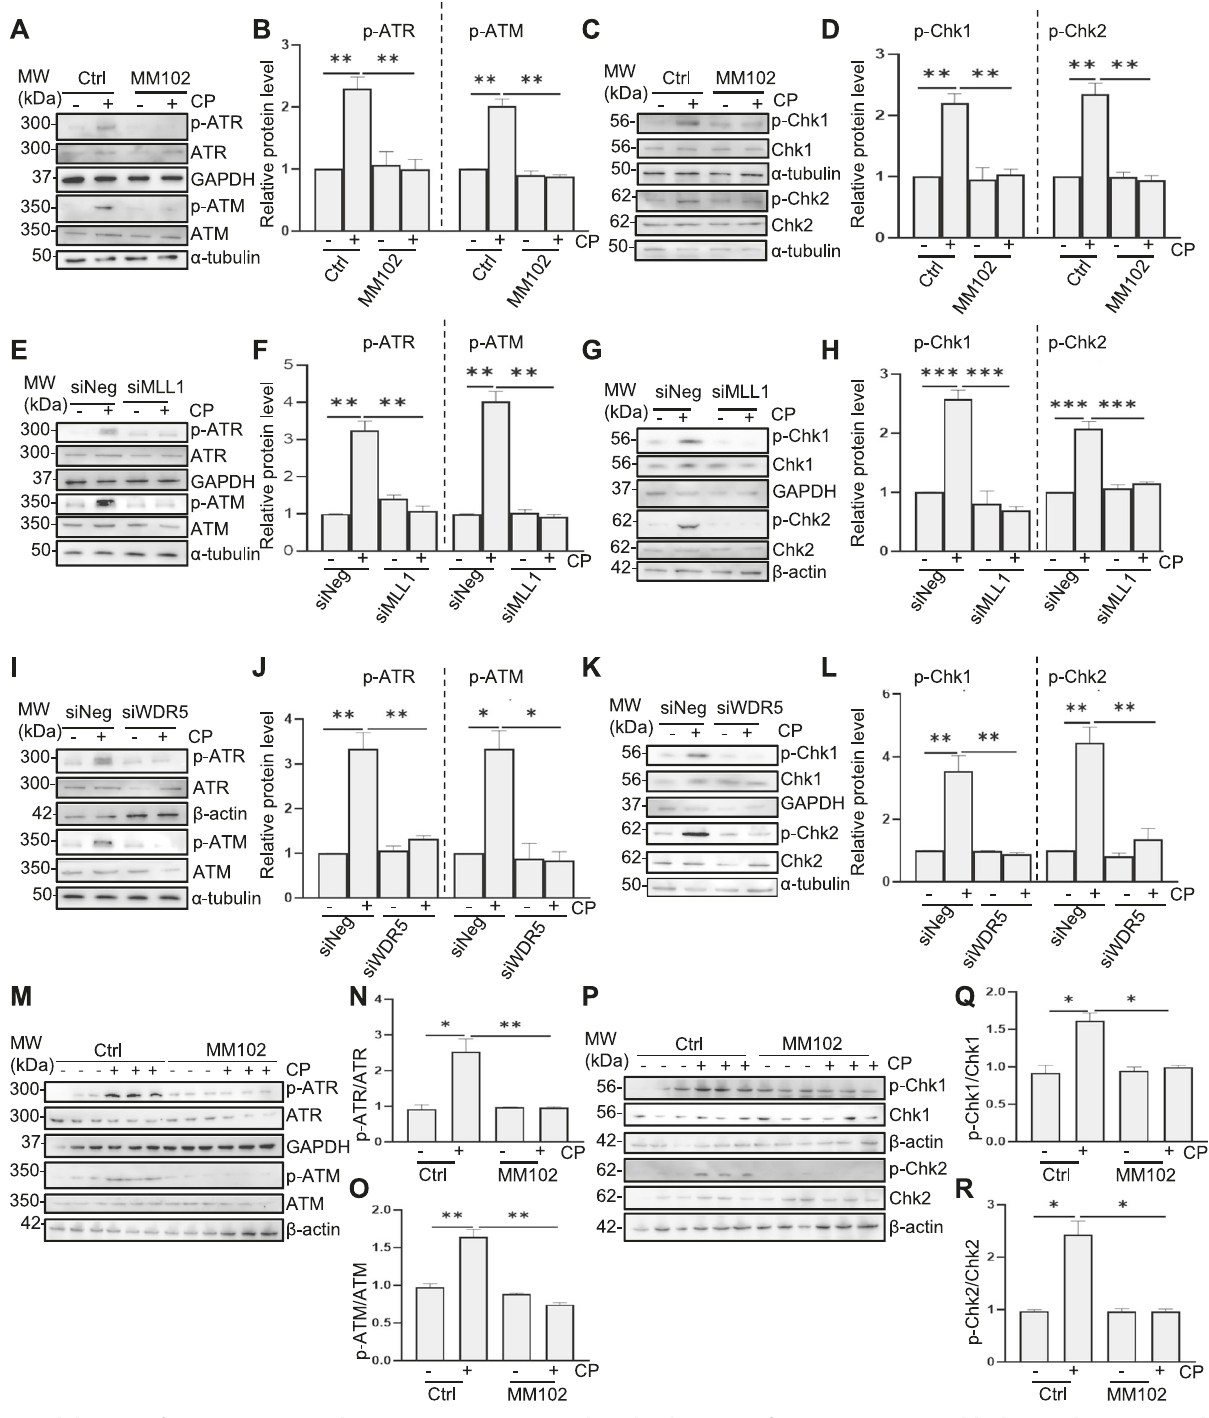
Fig. 7 Inhibition of MLL1/WDR5 with MM102 or siRNA-mediated silencing of MLL1 or WDR5 blocks cisplatin (CP)-induced phosphorylation of ATM, ATR, Chk1, and Chk2 in cultured murine renal proximal tubular epithelial cells (RPTCs) and in kidneys. RPTCs were treated with MM102 (50 μ M) or transfected with siRNA targeting MLL1 or WDR5 and then exposed to CP (20 μ M) for an additional 24 h. Mice were intraperitoneally injected with MM102 (15 mg/kg) 2 h before the CP (20 mg/kg) injection, and then given the same dose daily for three consecutive days. All the mice were euthanized 72 h after CP injection. A , E , I Representative immunoblots for ATR, phosphorylated ATR (p-ATR), ATM, and phosphorylated ATM (p-ATM) in RPTCs. B , F , J Expression levels of p-ATR and p-ATM levels were quanti fi ed by densitometry and normalized with total ATR and ATM, respectively. C , G , K Representative immunoblots for phosphorylated Chk1 (p-Chk1), Chk1, phosphorylated Chk2 (p-Chk2), and Chk2 in RPTCs. Expression levels of those proteins were quanti fi ed by densitometry; p-Chk1 and p-Chk2 were normalized with total Chk1 and Chk2, respectively ( D , H , L ). Expression of p-ATR, ATR, p-ATM, ATM ( M – O ) and Chk1, Chk2, p-Chk1, and p-Chk2 ( P – R ) in mice were quanti fi ed by densitometry and normalized as indicated. Values are mean ± SD. A representative result from at least three experiments was shown. * P < 0.05, ** P < 0.01, *** P <